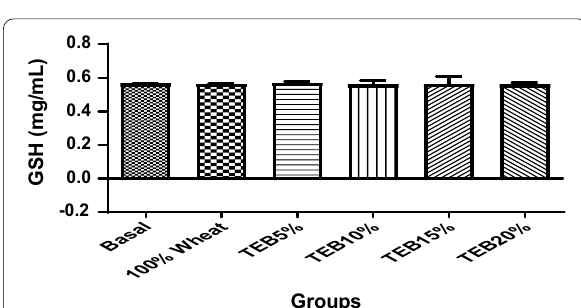
Fig. 11 Effect of enzymatic tacca–wheat biscuit on albino Wistar rats by catalase activities. 100% Wheat: Rats fed with 100% wheat flour biscuit, TEB5%: Rats fed with 5% enzymatic tacca flour flour biscuit, TEB10%: Rats fed with 10% enzymatic tacca flour wheat flour biscuit, TEB15%: Rats fed with 15% enzymatic tacca flour 85% wheat flour biscuit, TEB20%: Rats fed with 20% enzymatic + tacca flour 80% wheat flour biscuit +